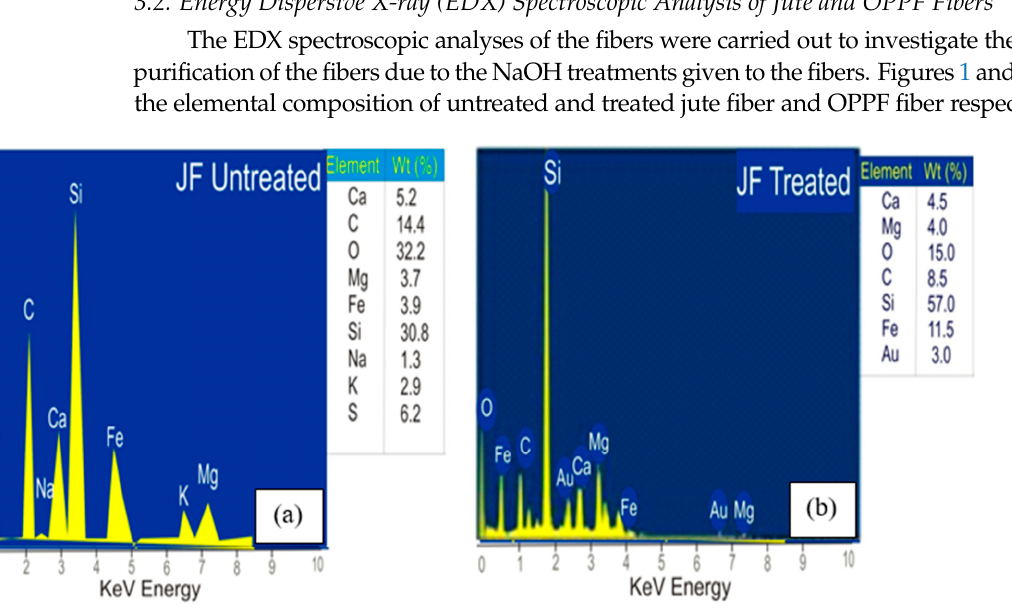
Figure 2. Elemental composition of ( a ) untreated OPPF fiber and ( b ) treated OPPF Fiber. Figures 1 and 2 revealed the presence of elements such as silicon, oxygen, iron, cal- cium, carbon, gold, and magnesium. Potassium, sodium, and sulfur were also discovered in the untreated jute fiber, which are regarded as impurities. The alkaline treatment given to the fiber caused the removal of these impurities and the presence of gold was discov- ered in the treated jute along with both treated and untreated OPPF fibers. The EDX anal- ysis also showed the presence of silica in the form of silicon and oxygen. Silica is known to be a hard ceramics material that improves the strength of a polymer matrix [33,34]. 3.3. Surface Morphology of the Jute and OPPF Fibers Figures 3a and 4a show the presence of impurities such as lignin and hemicelluloses on the surface of the fibers with respective flaky and cloudy like appearances which are gums when compared to Figures 3b and 4b that shows fibers with rough and exposed surface; the impurities have been removed as a result of the chemical treatment given to the fibers [35]. The reduction in the amount of lignin and hemicellulose brings about an